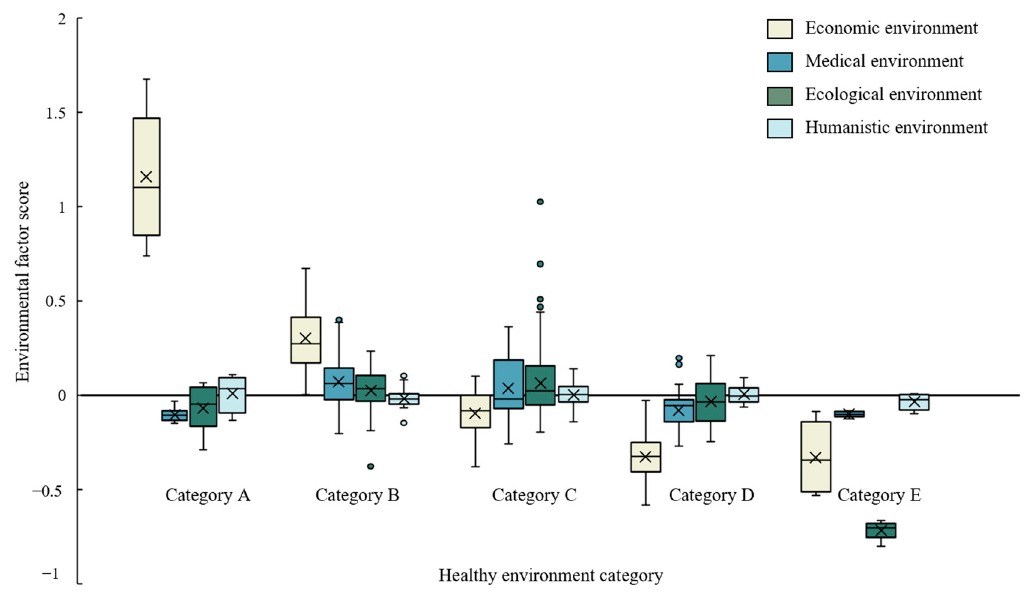
Figure 4. Distribution of four environmental factors in five healthy environments.